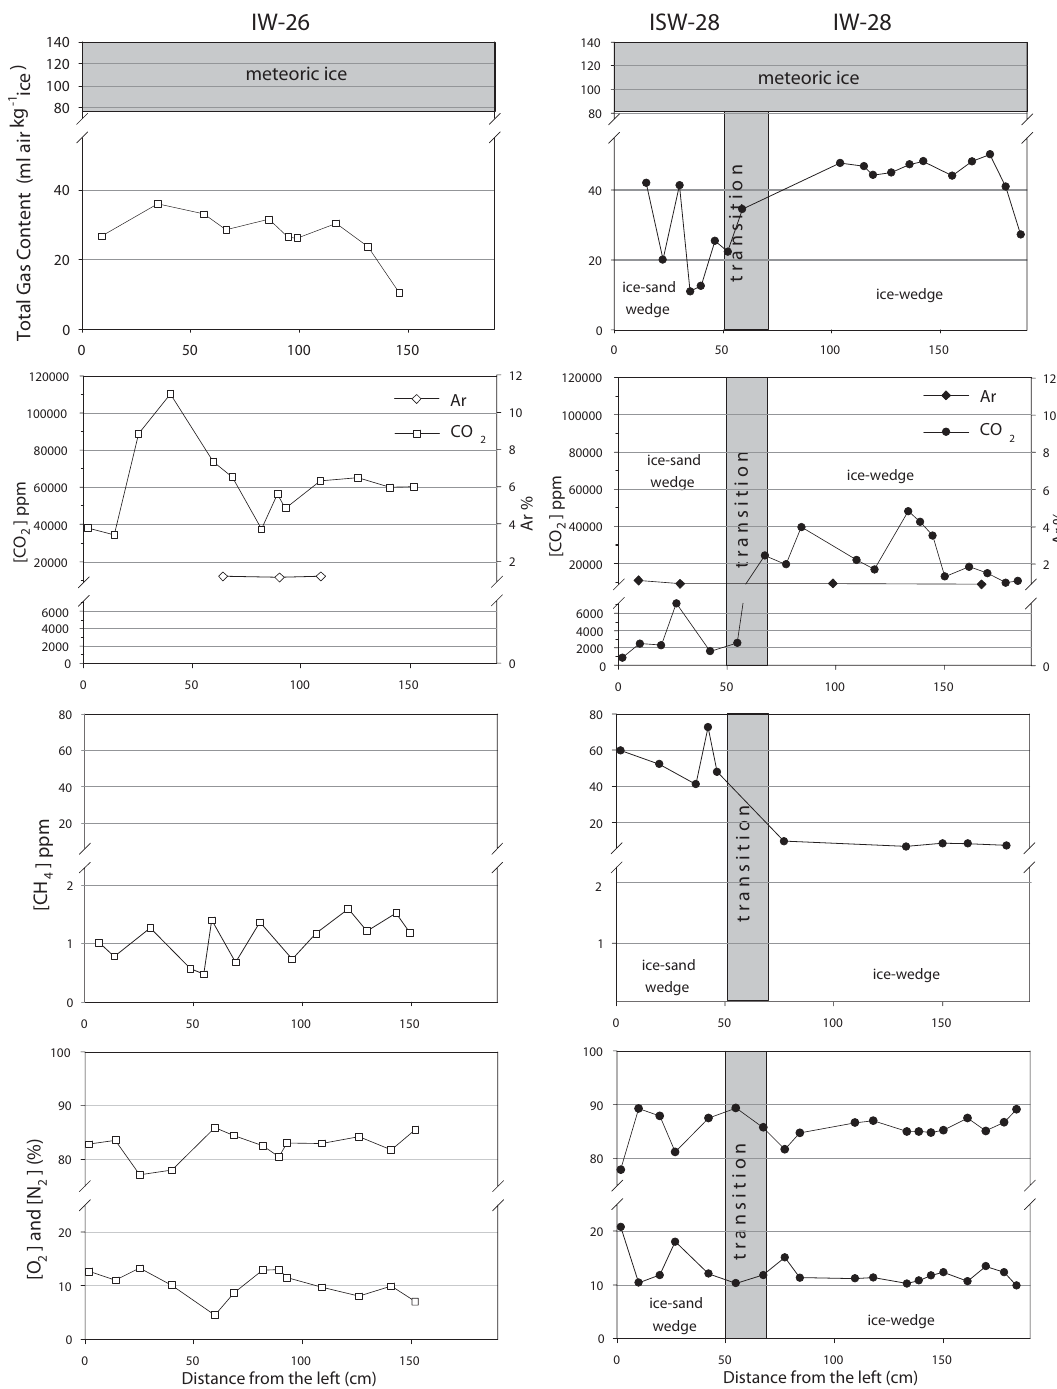
Fig. 7. Gas properties of ice wedges IW-26 (left) and ISW-28/IW-28 (right).